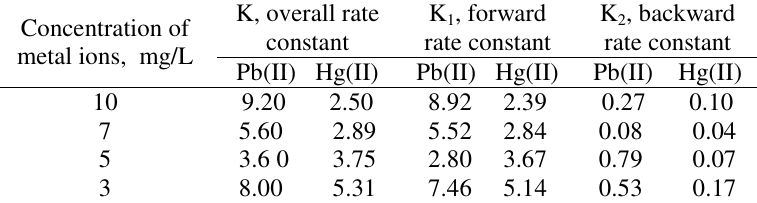
Table 4. Rate constants for the removal of lead and mercury (CSC).